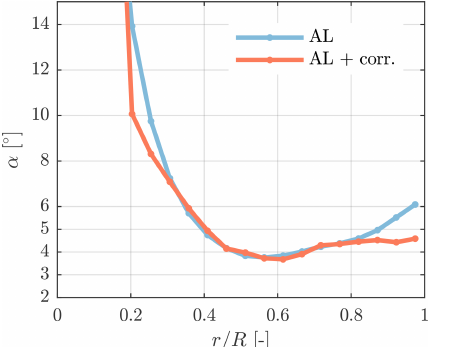
Figure 10. Angle of attack with/without smearing correction on the